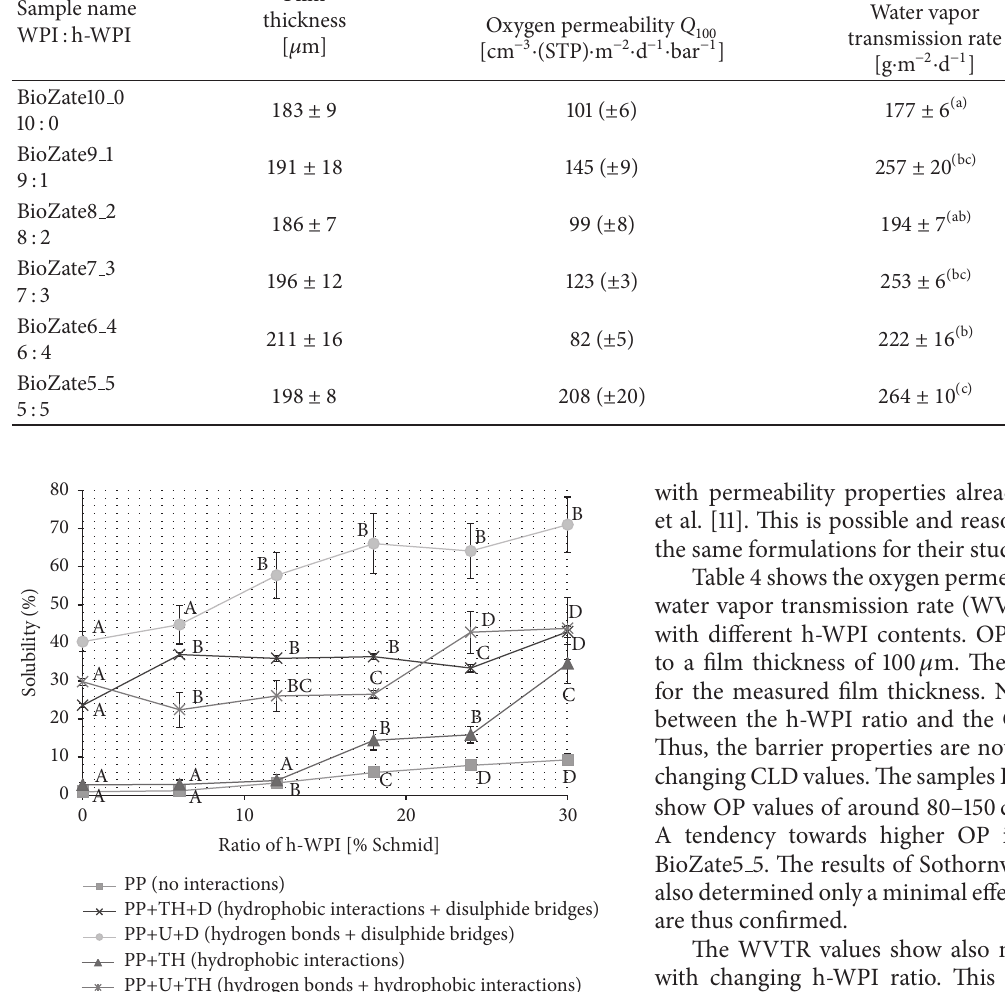
Figure 4: Protein solubility in WPI-based coatings dependent on the h-WPI ratio (different letters indicate statistically significant differences ( 𝑝 < 0.05